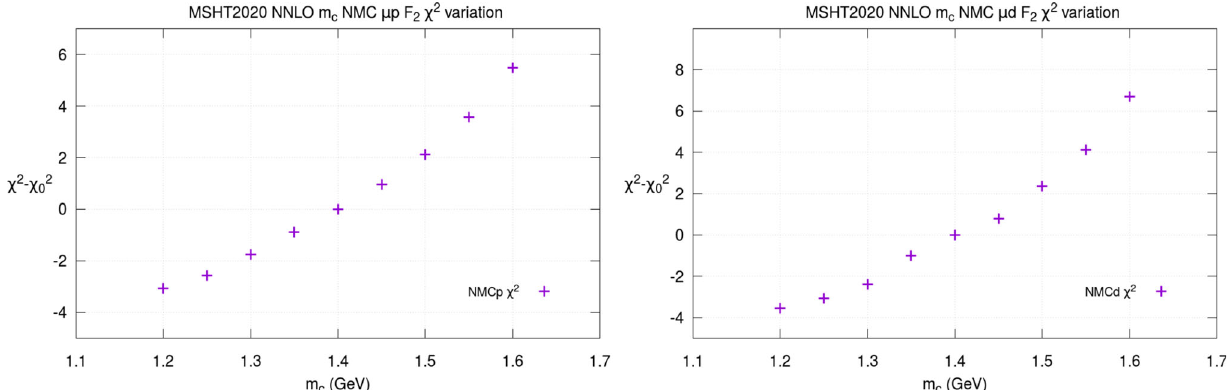
) = 0 . 118 for (left) the NMC F p Z